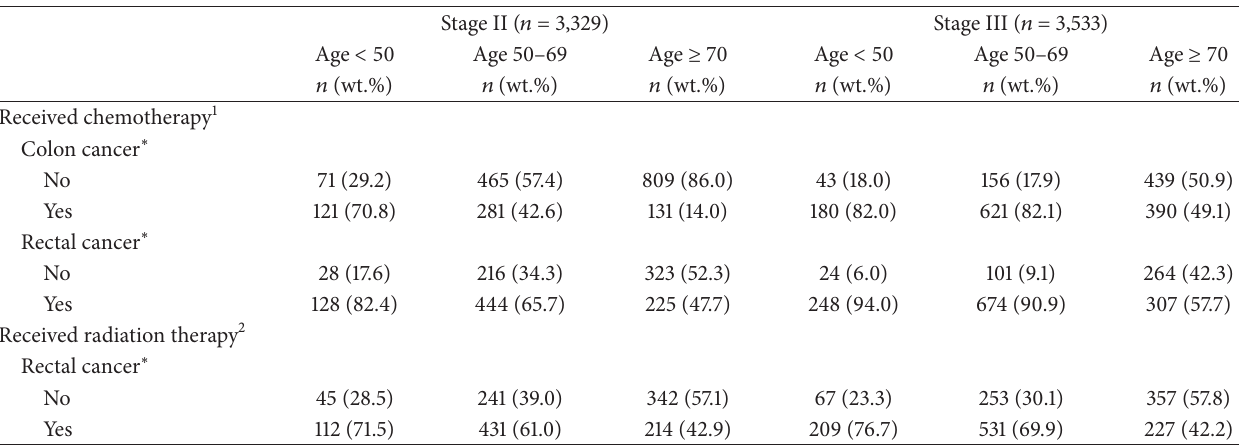
Table 4: Receipt of chemotherapy and radiation therapy among 6,862 patients diagnosed with stages II and III colorectal cancer, 1990–2010, by age and stage at